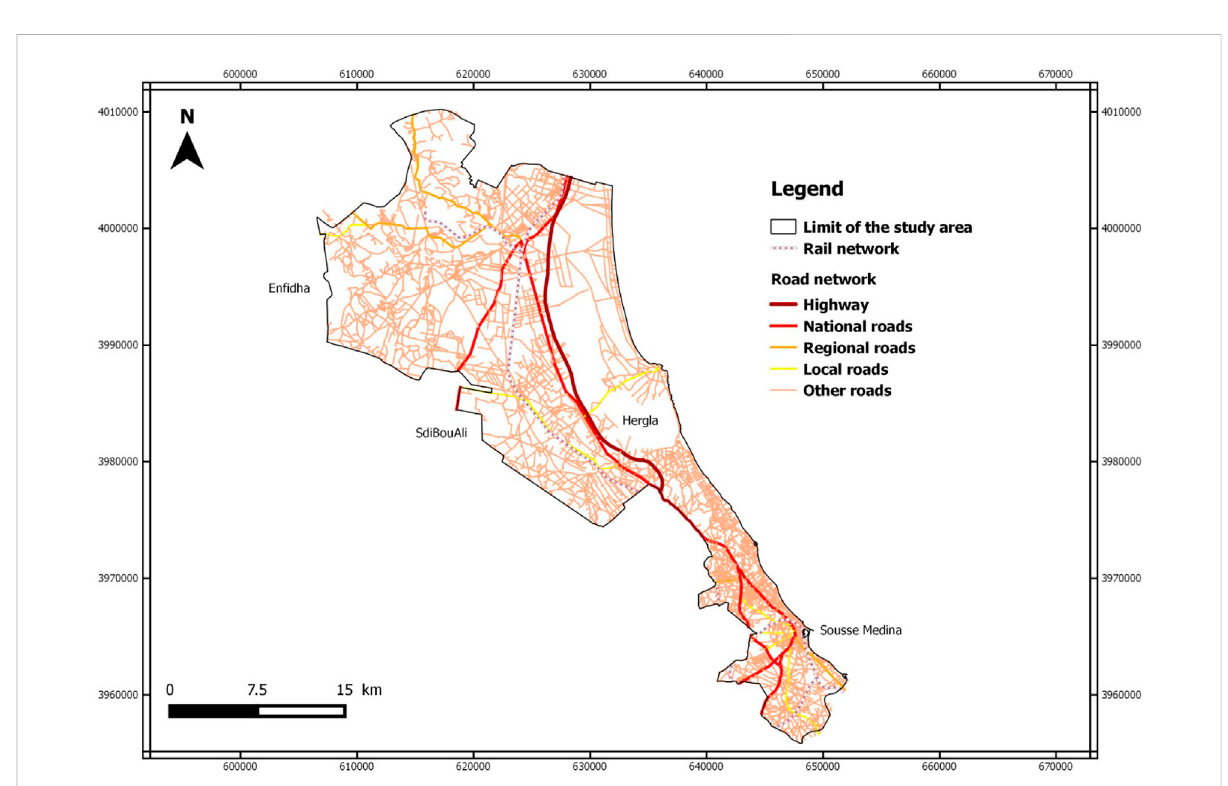
FIGURE 12 Urbanization map of the Sousse region.